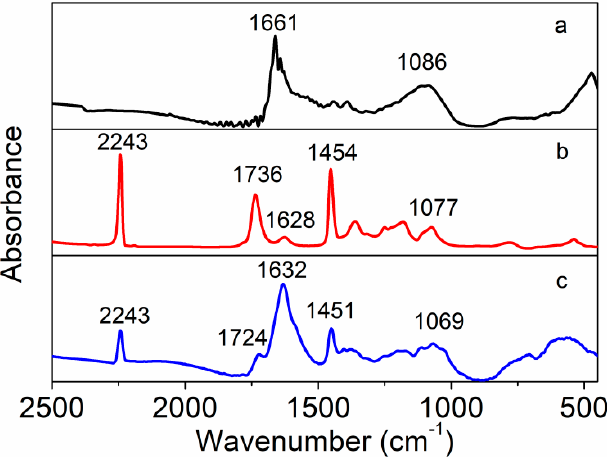
Figure 2. FTIR spectra of ( a ) amino ‐ MWCNTs, ( b ) PAN polymer and ( c ) PAN grafted amino ‐ MWCNT nanocomposites.